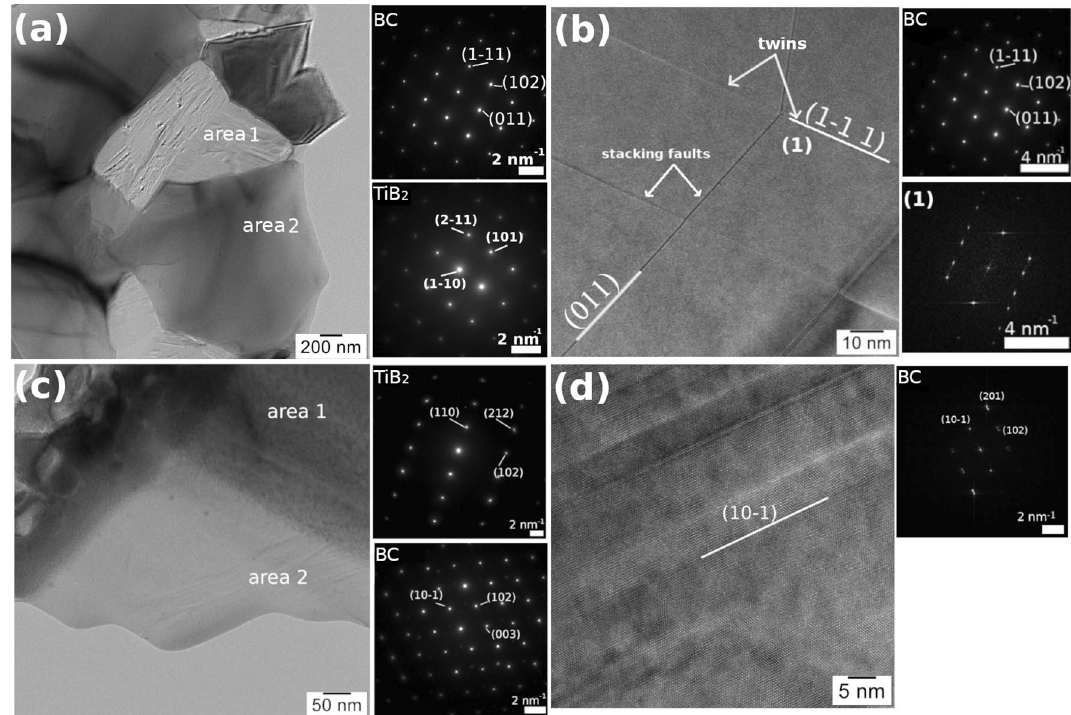
Figure 3. Sample E from the free end of the TiB 2 -BC bar after bending test at 1800 °C; ( a ) CTEM and selected area electron diffraction (SAED) images of area 1 = BC and area 2 = TiB 2 ; ( b ) HRTEM and SAED images showing stacking faults and twins (1) in the BC grain. Sample F near the fracture in the TiB 2 -BC bar after bending test at 1800 °C; ( c ) CTEM and SAED images where area 1 = TiB 2 and area 2 = BC crystal grains; ( d ) HRTEM and SAED images showing nano-twins in BC.